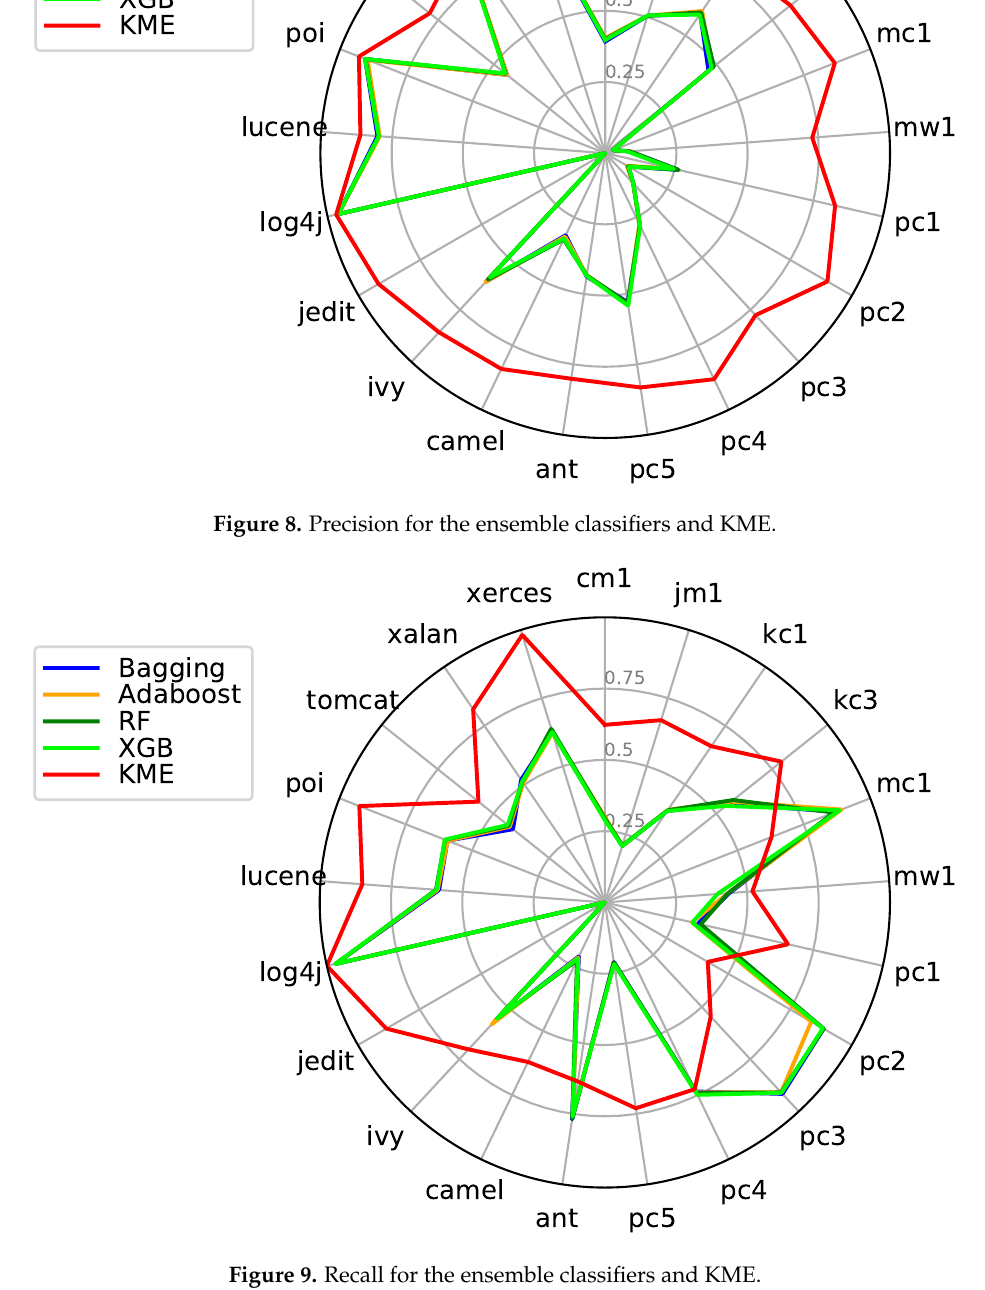
Figure 9. Recall for the ensemble classifiers and